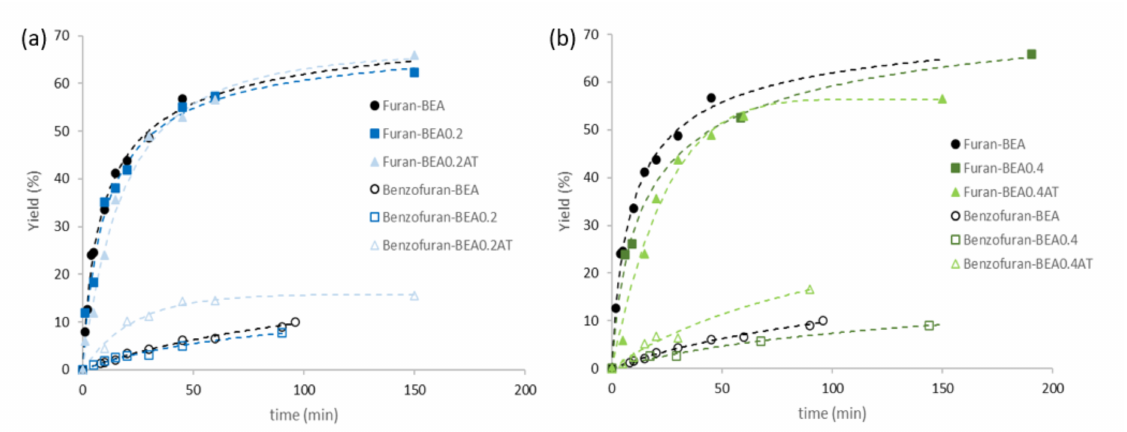
Figure 3. Product yield as a function of reaction time for parent and treated BEA zeolite. Effect of concentration of NaOH ( a ) 0.2 M and ( b ) 0.4 M on the desilication and catalytic activity of BEA. Full symbols for furane and empty symbols for benzofuran. (The dashed curves represent calculated values obtained from the kinetic